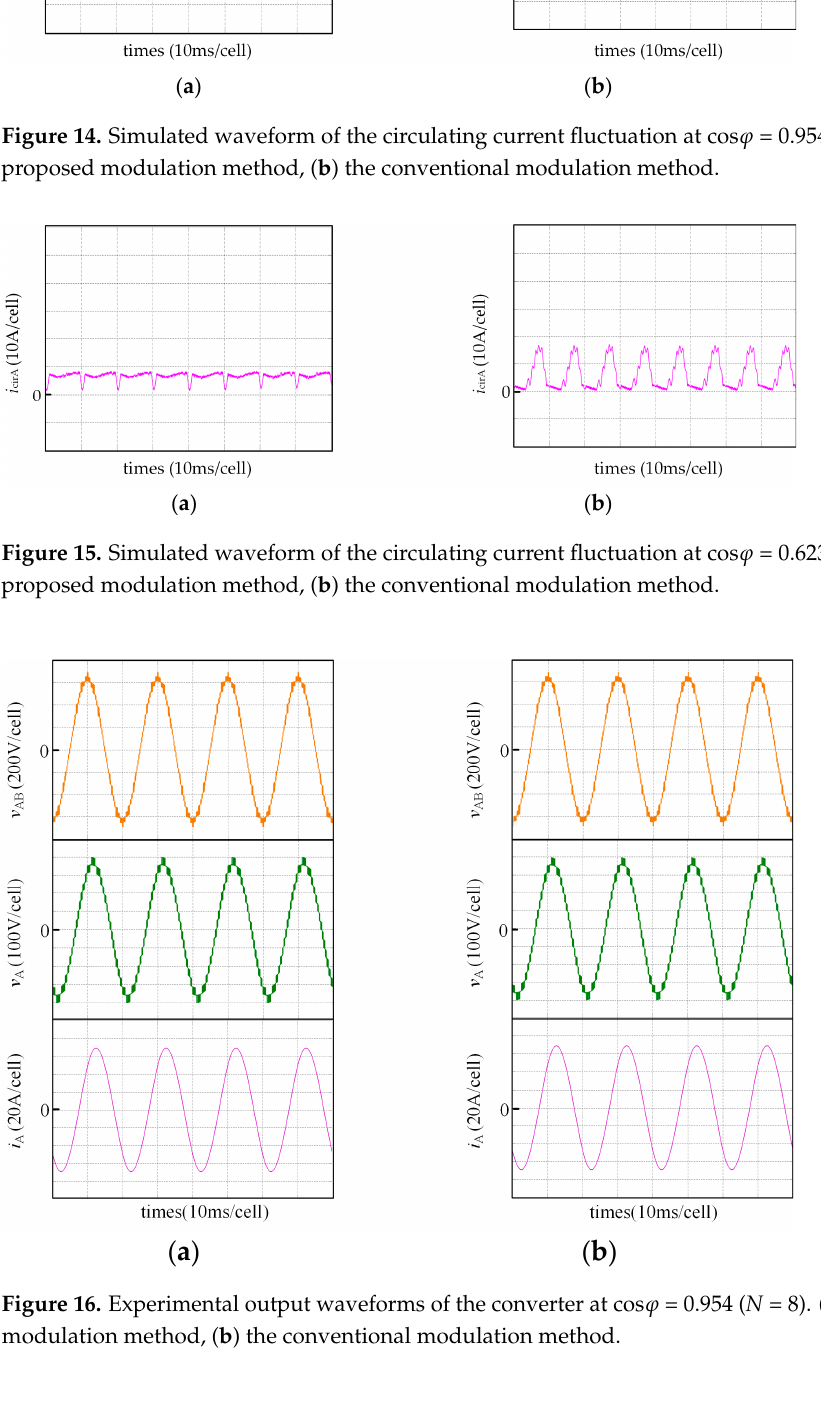
( b ) Figure 17. Experimental output waveforms of the converter at cos φ = 0.623 ( N = 8). ( a ) The proposed modulation method, ( b ) the conventional modulation method. ( a ) ( b ) Figure 18. The total harmonic distortion of the output current at cos φ = 0.954 ( N = 8). ( a ) The proposed modulation approach, ( b ) the conventional modulation approach.